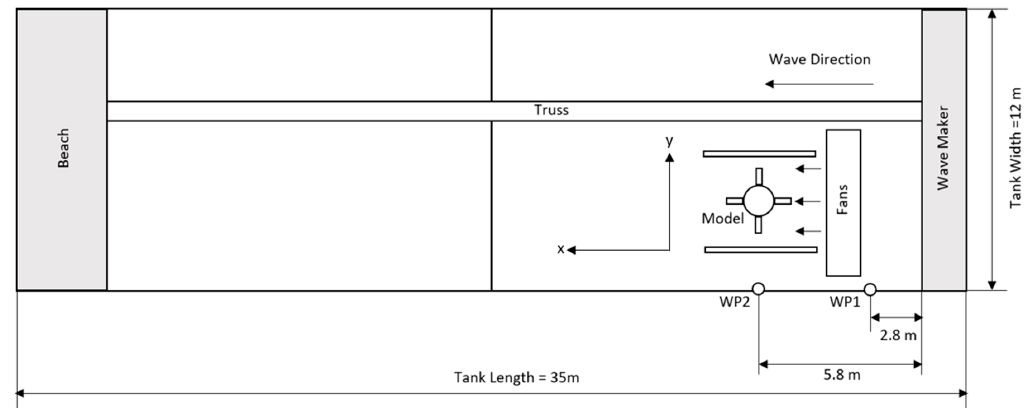
Figure 3. Plan view of TLPWT experimental setup (not to scale).